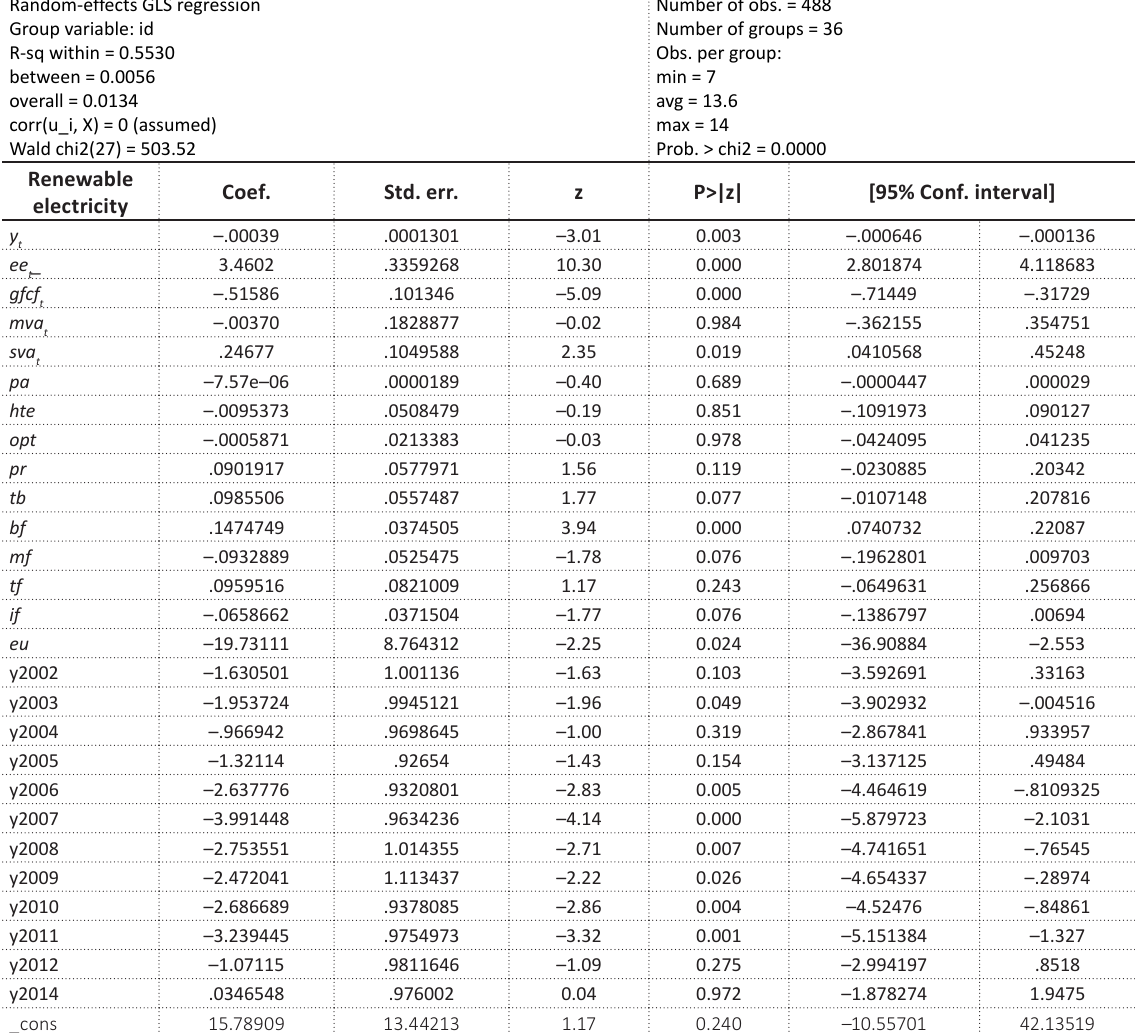
Table 1. The empirical results of economic, social, and institutional drivers’ influence on Smart Grid improvements (measured as REO) in OECD countries Random-effects GLS regression Group variable: id R-sq within = 0.5530 between = 0.0056 overall = 0.0134 corr(u_i, X) = 0 (assumed) Wald chi2(27) =